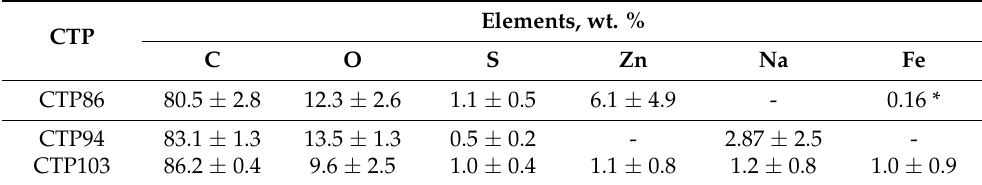
Table 5. The elemental composition of pyrolyzed CTPs. CTP